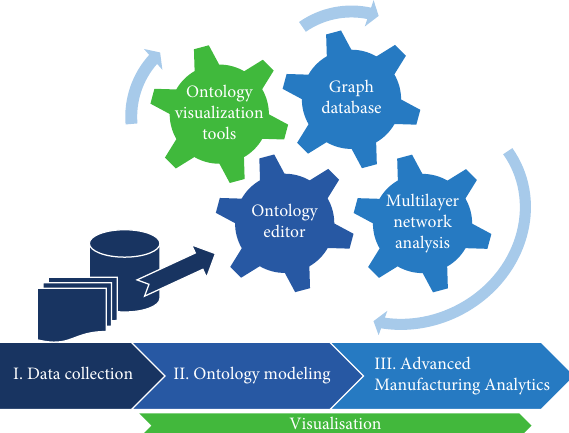
Figure 2: The main steps of the developed